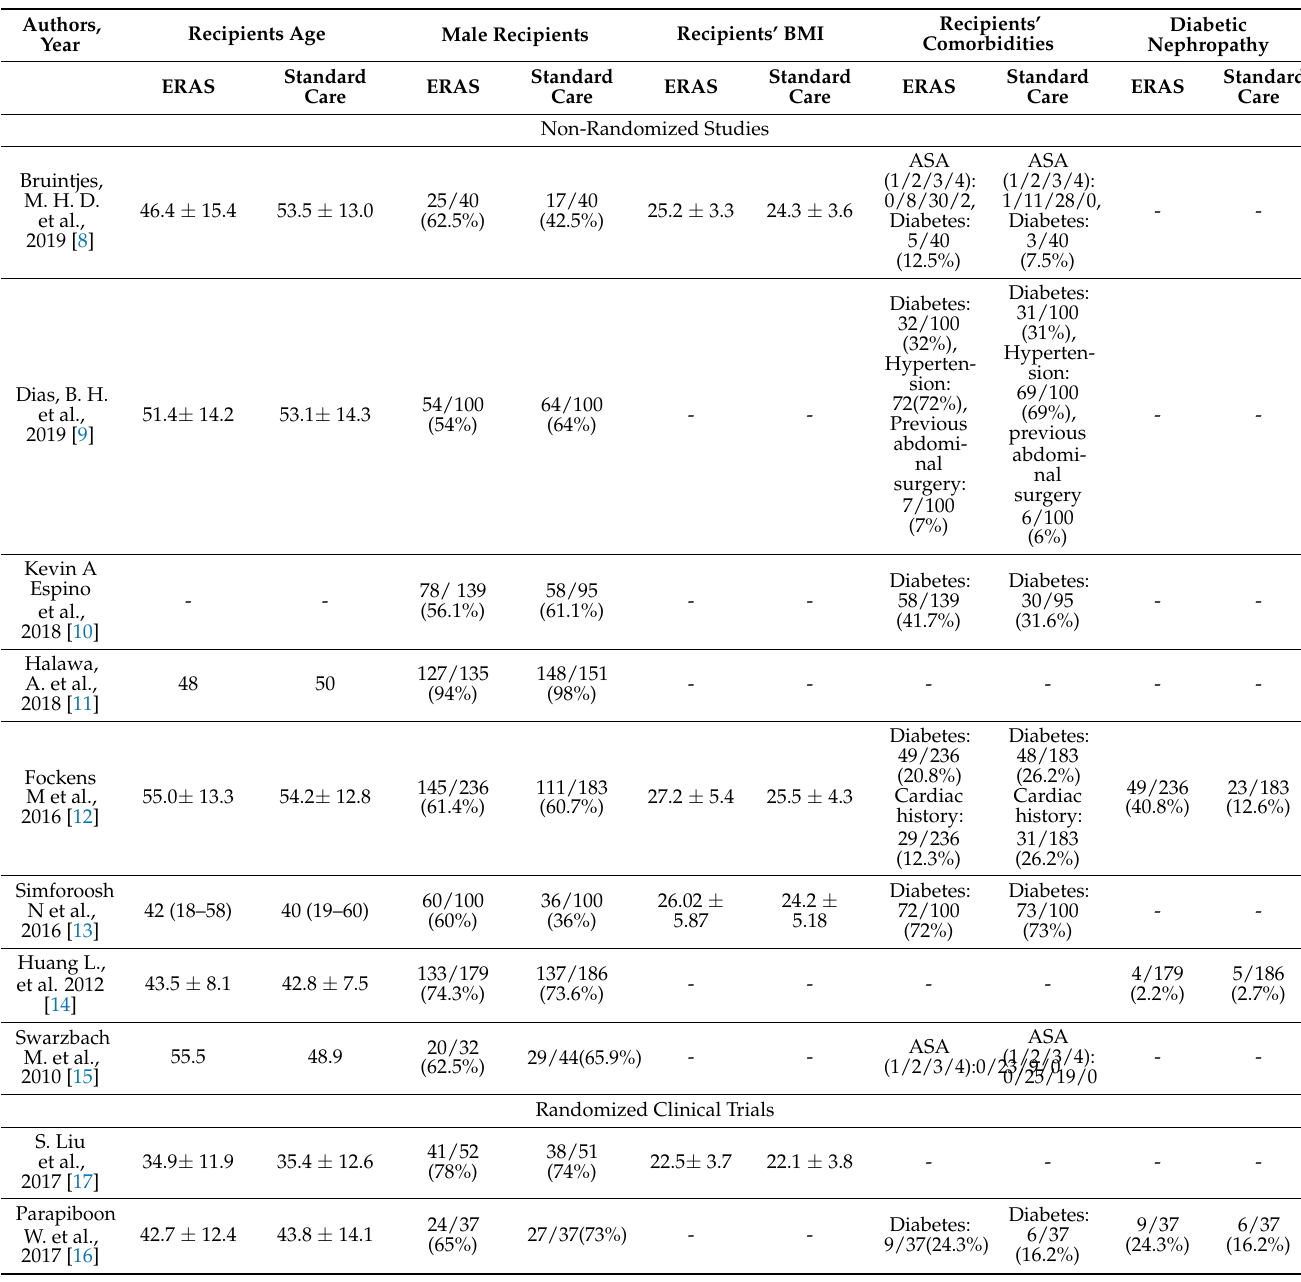
Table 3. Recipients’ background